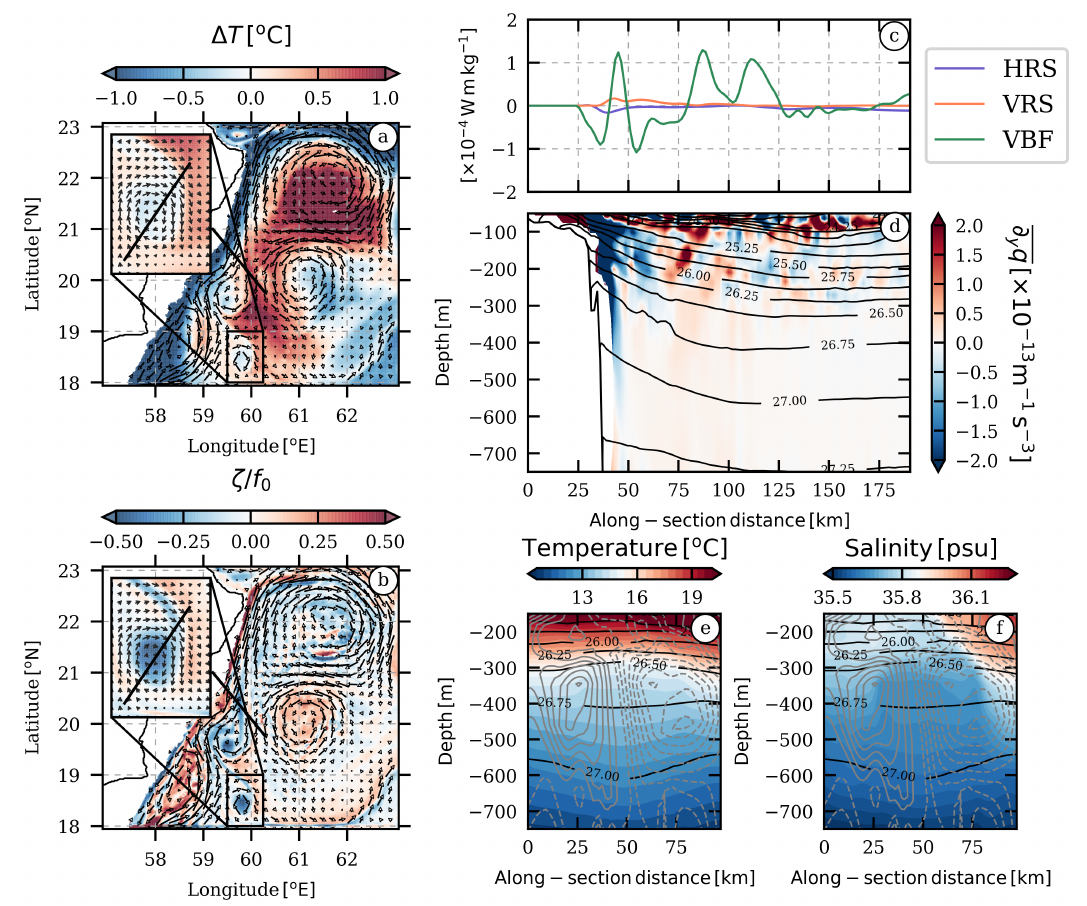
Figure 8. Dynamical structure of OCC at depth during the Summer monsoon. ( a ) Temperature anomaly and ( b ) surface relative vorticity normalized by the Coriolis frequency ( f 0 ) at 360 m depth. Arrows stand for the velocity vectors. ( c ) Energy transfer terms averaged over a month and integrated from the surface down to 150 and 750 m depth and ( d ) vertical section of the horizontal gradient of Ertel potential vorticity averaged over a month. Contours of density are superimposed. (section drawn in panel ( a , b )). ( e , f ) Vertical section of temperature and salinity. Contours of (black) density and (grey) cross-section velocity component are superimposed (section drawn in inset in panel ( a , b